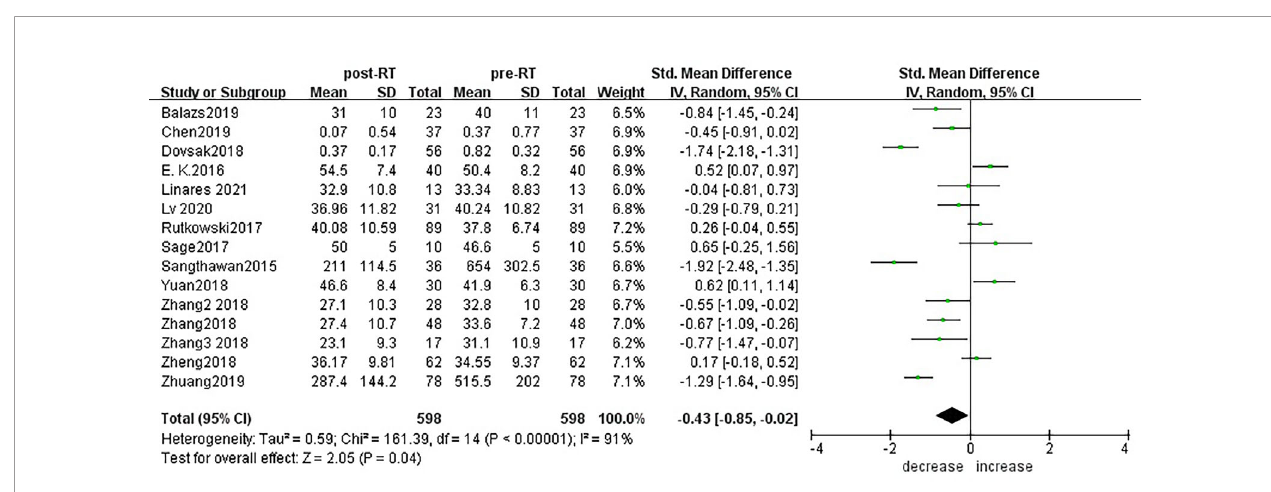
FIGURE 3 | Forest plot for changes of CD4+T lymphocytes after radiotherapy compared with before radiotherapy. decrease: CD4+T lymphocytes were less after radiotherapy than before. increase: CD4+T lymphocytes were increased after radiotherapy than